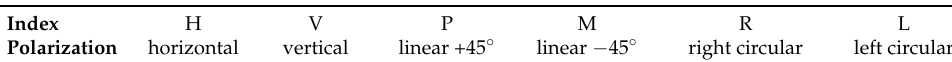
Table 1. Index and polarization state